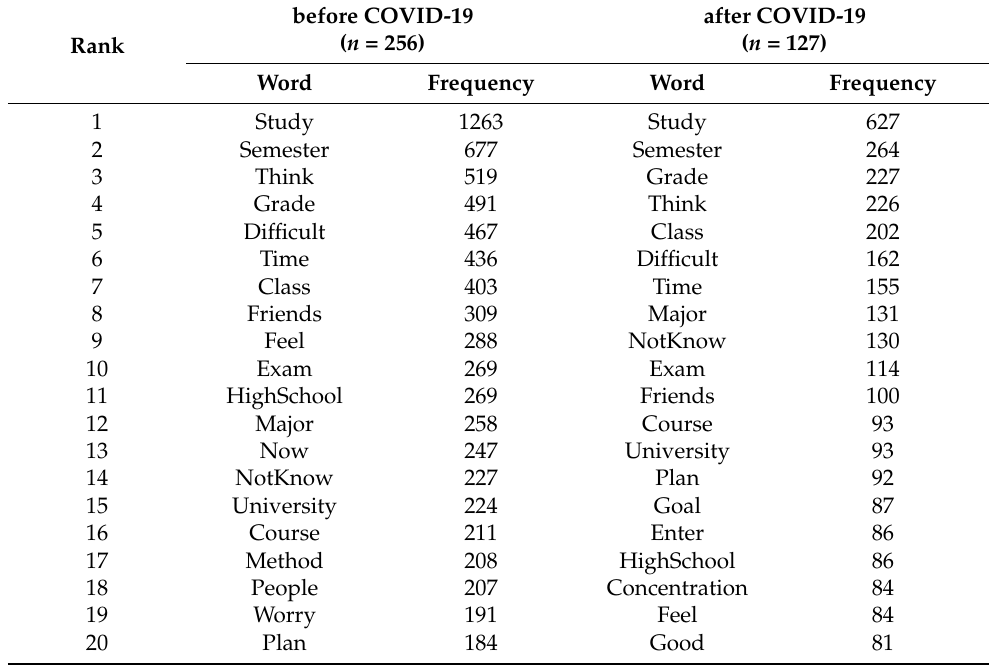
before COVID-19 ( n = 256)